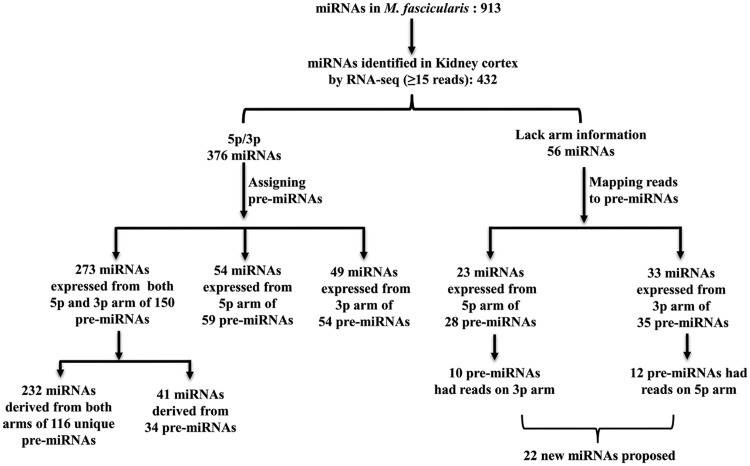
Mapping 432 expressed miRNAs to respective pre-miRNAs.